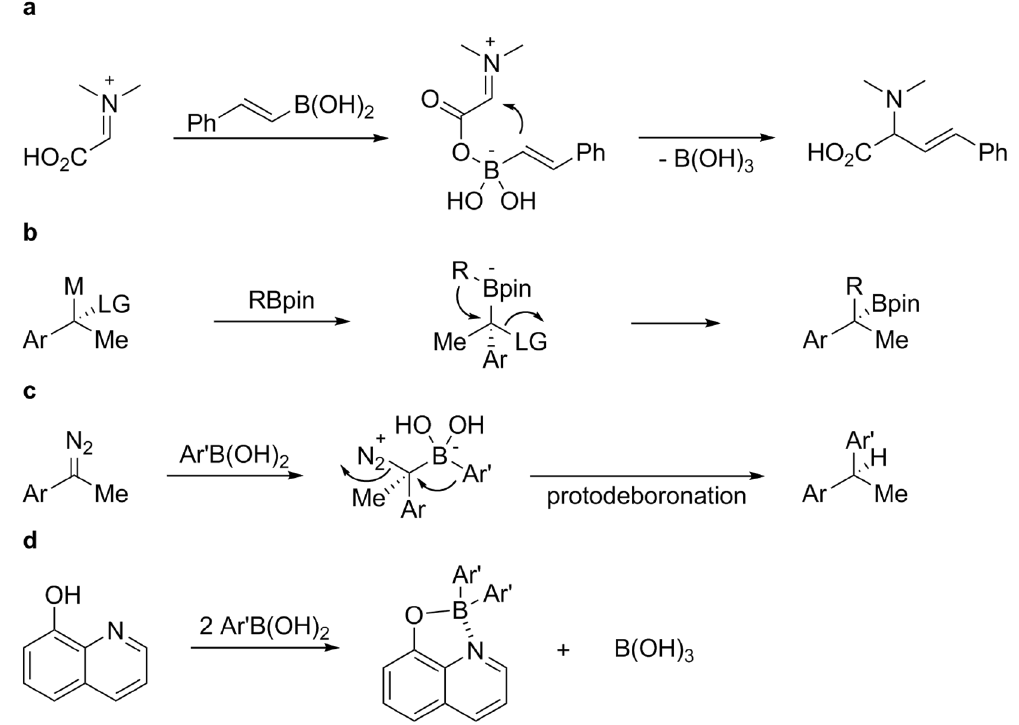
Figure 1. Representative examples of transition metal-free group migration from boronic acids. Group migration from boron to carbon: ( a ) Typical example of Petasis boronic acid-Mannich reaction. ( b ) Stereospecific 1,2-migration of a boronate complex to give a homologated boron intermediate bearing a quaternary stereogenic center ( c ) Reductive coupling between boronic acid and diazo compound through an α -transfer. Group migration from boron to boron: ( d ) Group migration between boronic acids in the presence of 8-hydroxyquinoline to afford a four-coordinate organoboron compound (this work). LG, leaving group, M, Li or Mg, Bpin, boronic acid pinaol